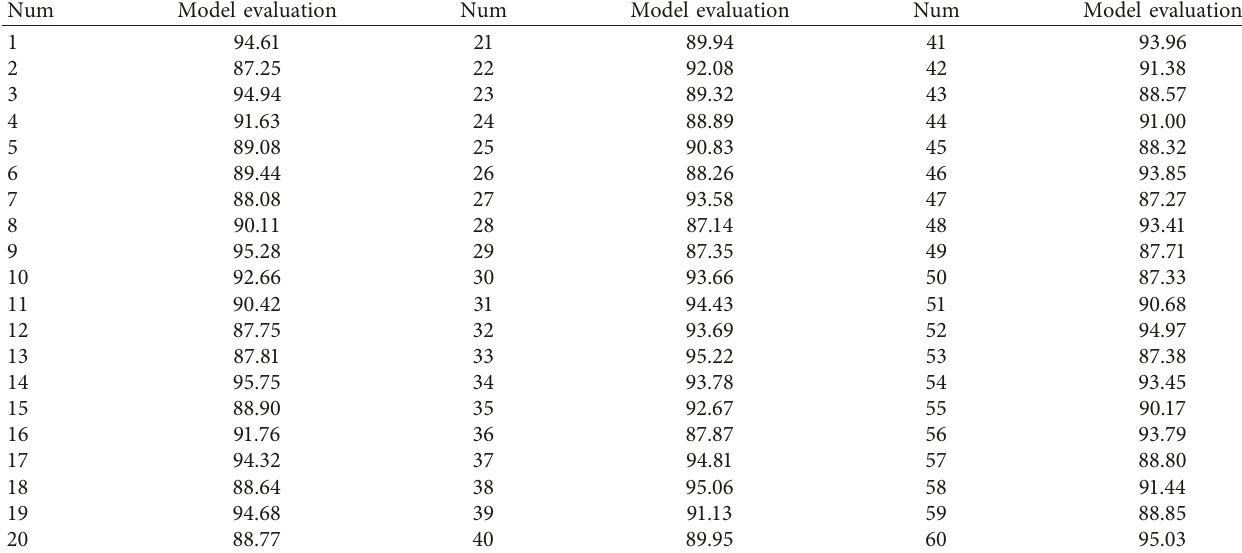
Table 1: Performance evaluation of the model proposed in this paper in the evaluation of ecotourism carrying capacity.